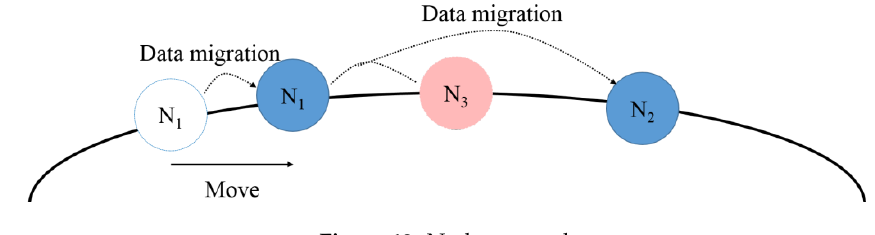
Figure 12. Node removal.